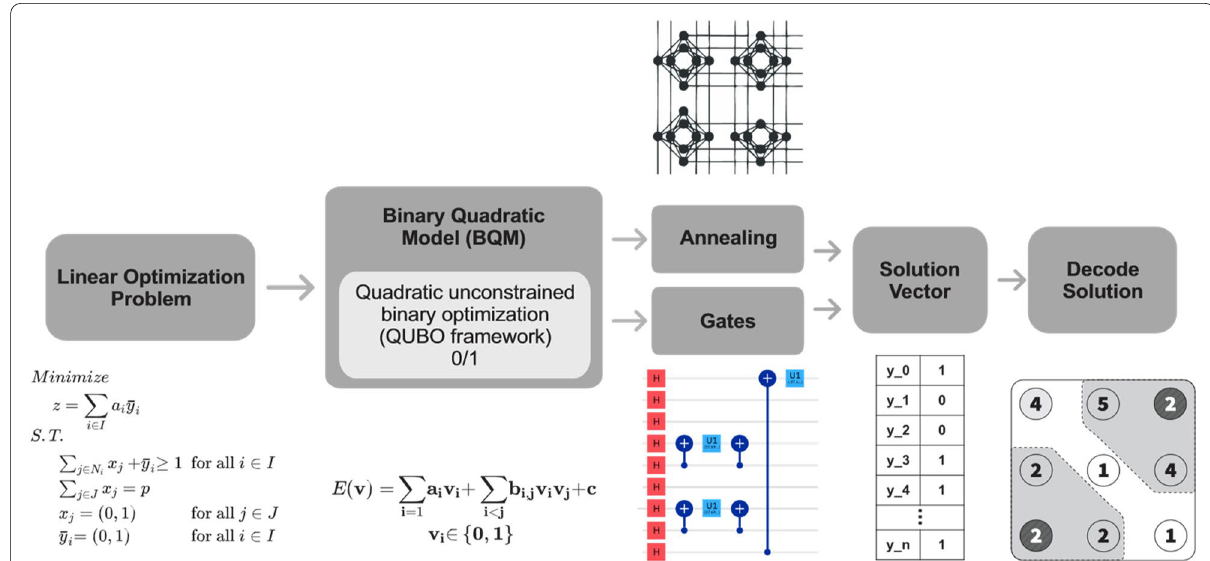
Fig. 1 Main steps for solving an integer programming problem in a quantum computer